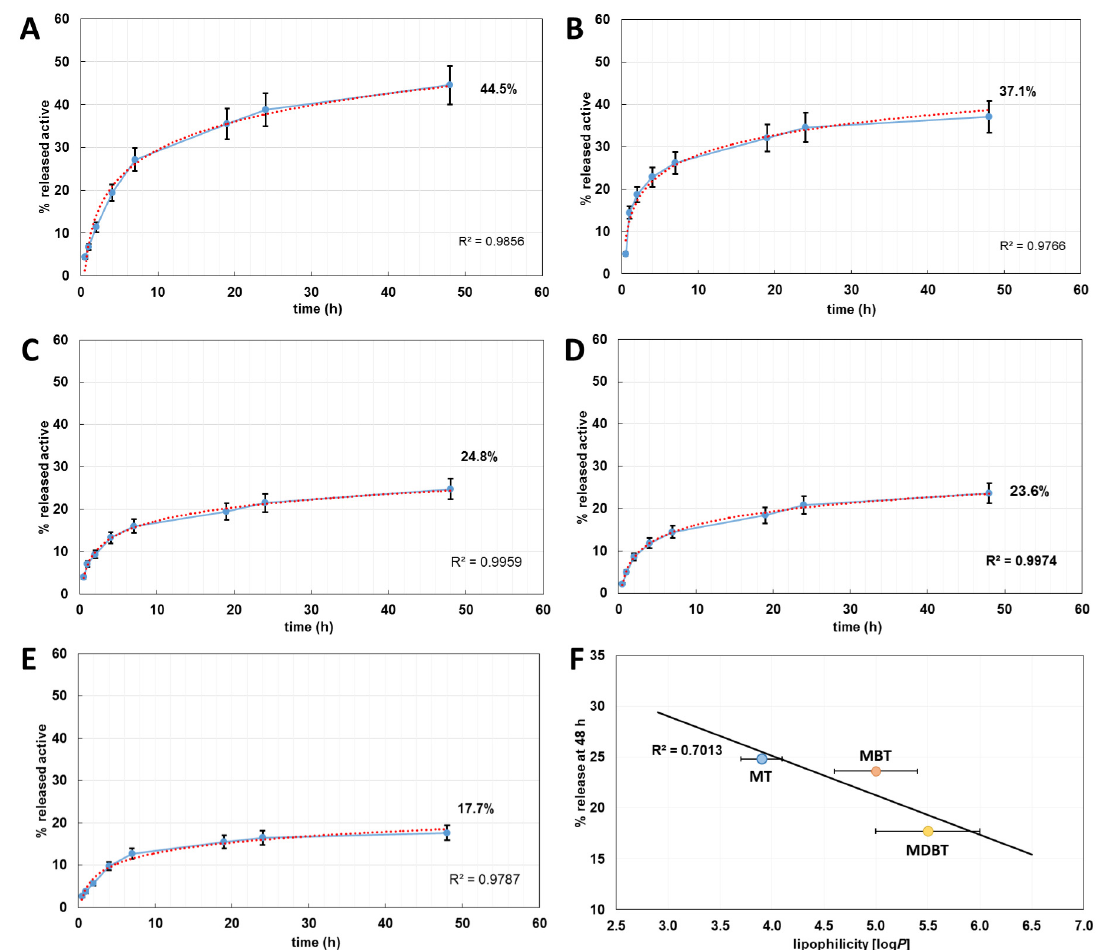
Figure 7. Release kinetics of various thymol containing softwood lignosulfonate microcapsules: ( A ) T_SLS-MCs ; ( B ) BT_SLS-MCs ; ( C ) MT_SLS-MCs ; ( D ) MBT_SLS-MCs ; ( E ) MDBT_SLS-MCs ; ( F ) correlation of relative amounts of released actives to lipophilicity of actives. For ( A ) to ( E ), a maximum standard deviation of 10% has been estimated. Regression curves were generated assuming first order kinetics.